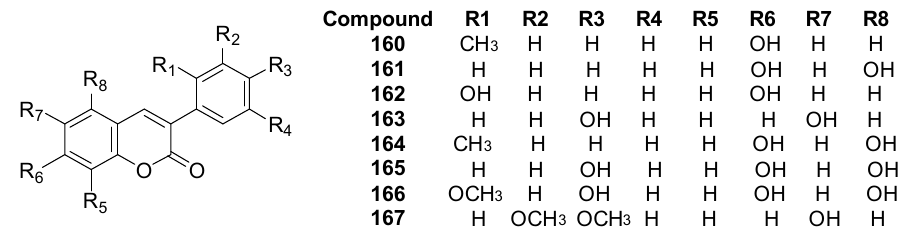
Figure 54. General structures of compounds 158a – e and 159a – e .